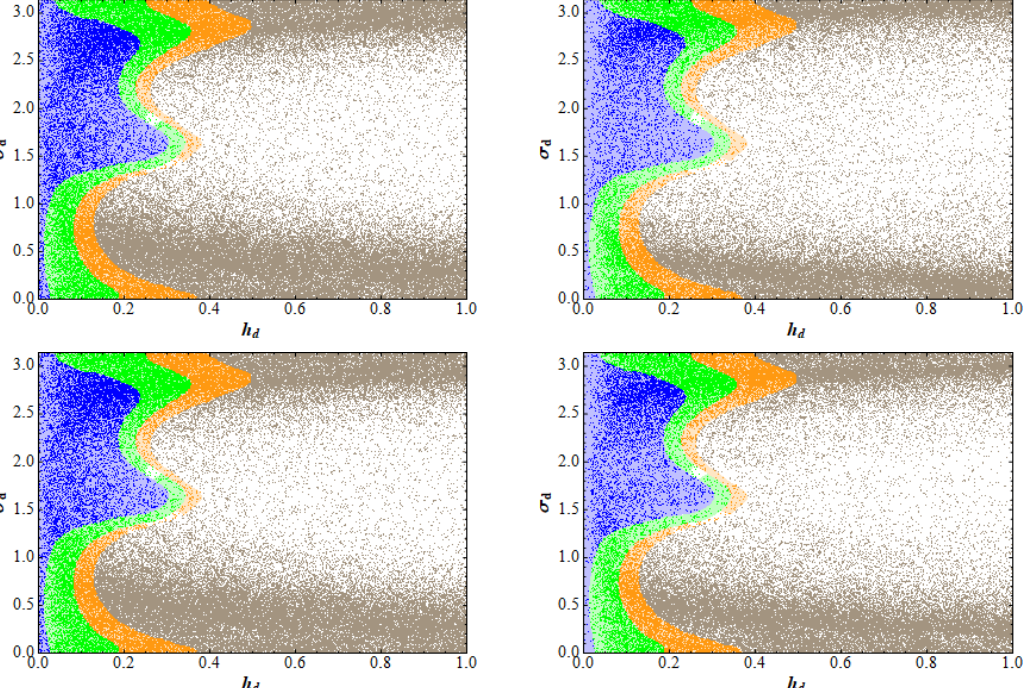
Figure 9. h d (cid:0) (cid:27) d scatter plots for the full sample of parameter space points, for g A = g B = 0 : 1 and v F =k = 0 : 1 (top left), g A = g B = 1 : 0 and v F =k = 0 : 1 (top right), g A = g B = 0 : 1 and v F =k = 1 : 0 (bottom left), and g A = g B = 1 : 0 and v F =k = 1 : 0 (bottom right). The blue represents the 68% CL experimental allowed region, the green represents the 95% CL region, and the orange represents the 99.7% CL region